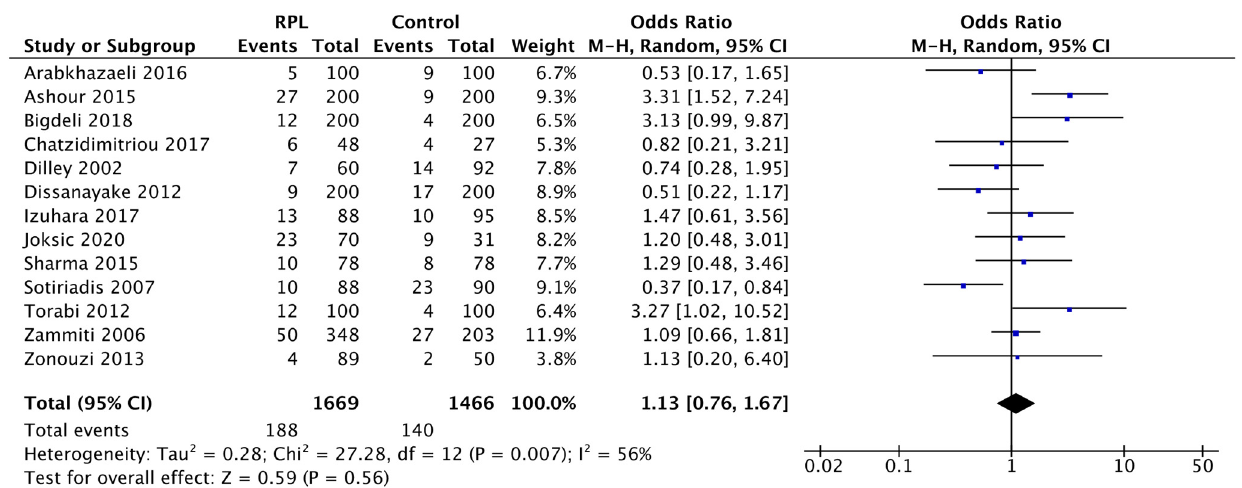
Figure 4. Forest plot of the association between H1299R heterozygous and RPL. The statistical value of every single study is expressed as OR. The horizontal black lines represent the confidence interval (95% CI). The blue squares indicate the weight of each study. The black diamond indicates the over ‐ all result of the statistical analysis. Heterogeneity is expressed as I 2 . Overall effect OR: 1.13 [0.76, 1.67]; p = 0.56.